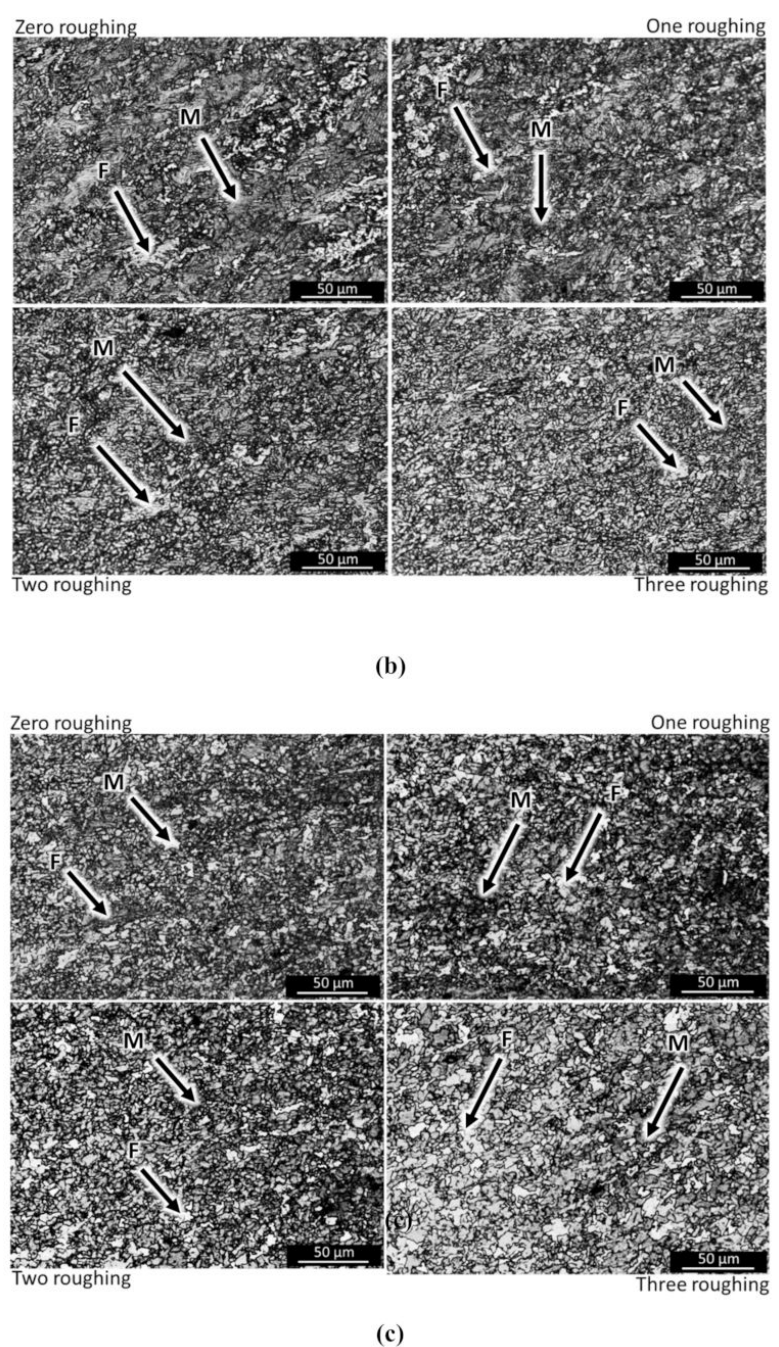
Figure 4. Optical microstructures of the present material subjected to the five-pass finishing simulations with di ff erent thermomechanical roughing passes schedules. The samples were quenched immediately after the: ( a ) 1st pass, ( b ) 3rd pass, and ( c ) 5th pass. Light regions are ferrite while the dark regions are martensite (prior